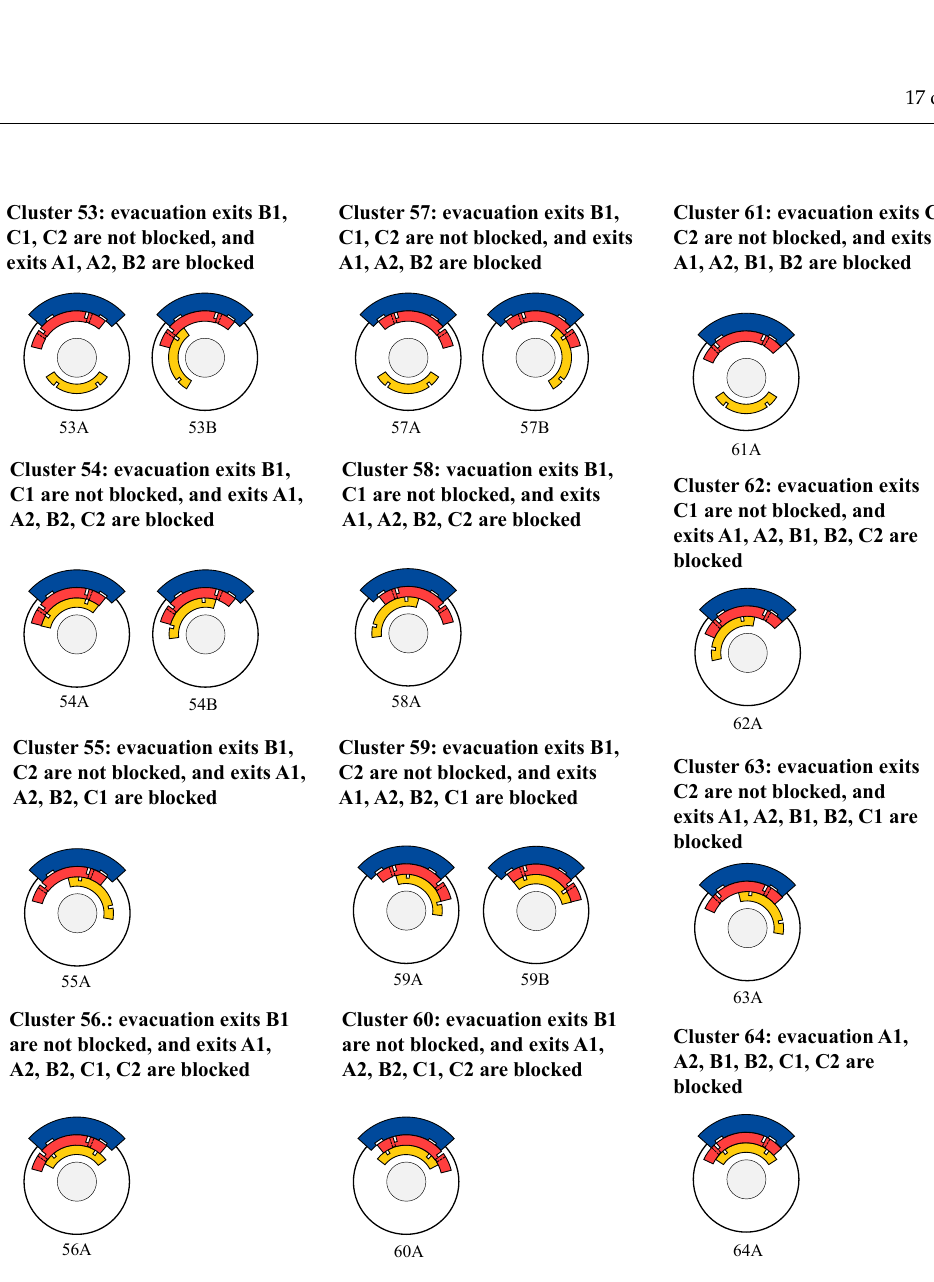
Figure 11. Typical layouts of the rotating auditorium for Clusters 53 to 64.